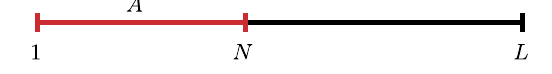
FIG. 1. The partition of the spin chain considered in the calculation of the